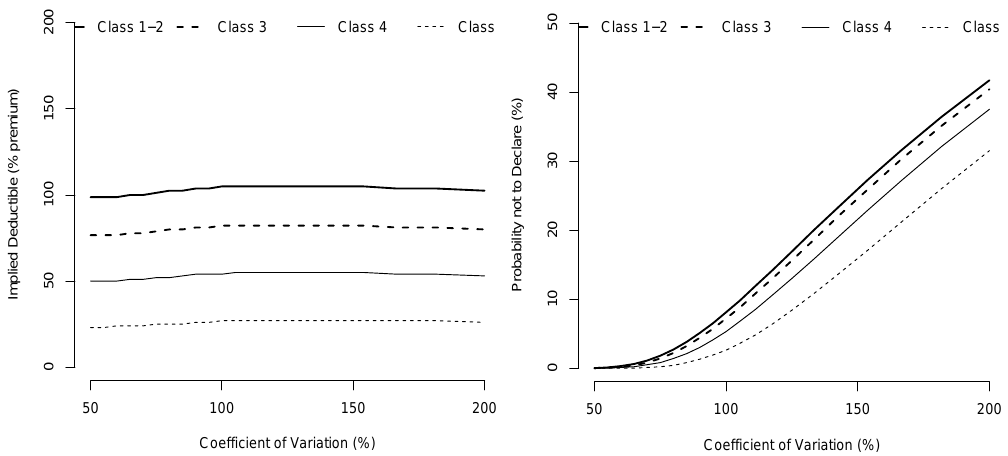
Figure 4. Value of the Deductibles, d (cid:63) s (expressed as a percentage of the premium P s ) and probability not to declare an accident, 1 − π (cid:63) s = P [ L < d (cid:63) s ] as a function of losses coefficient of variation (with a Gamma distribution).